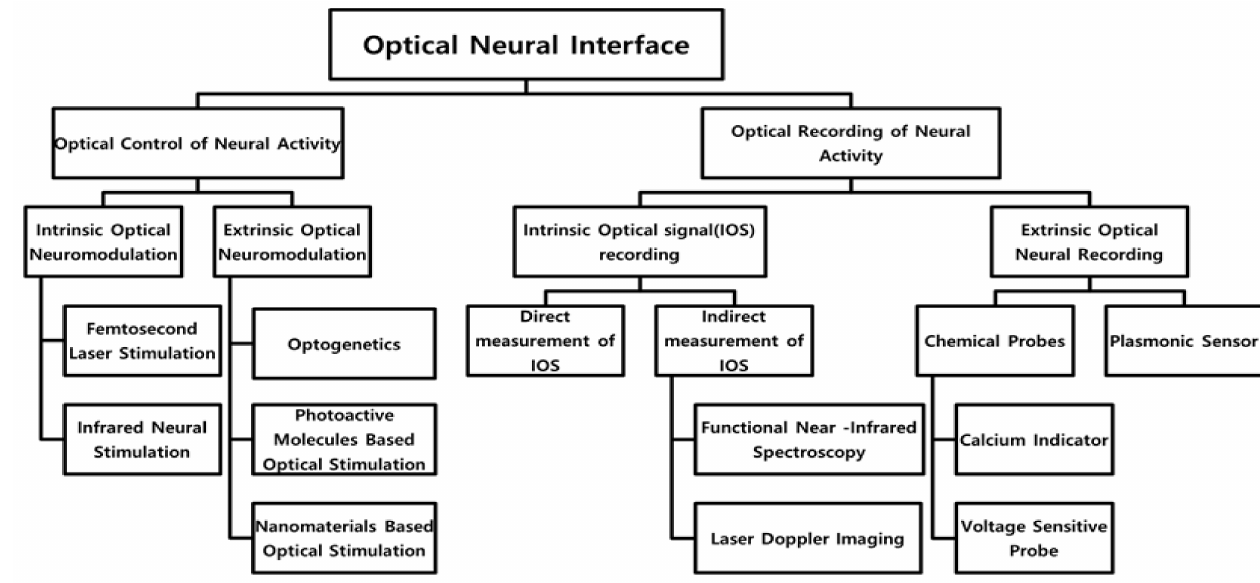
Figure 1. Optical neural interfaces consisting of an optical neural recording and an optical neural